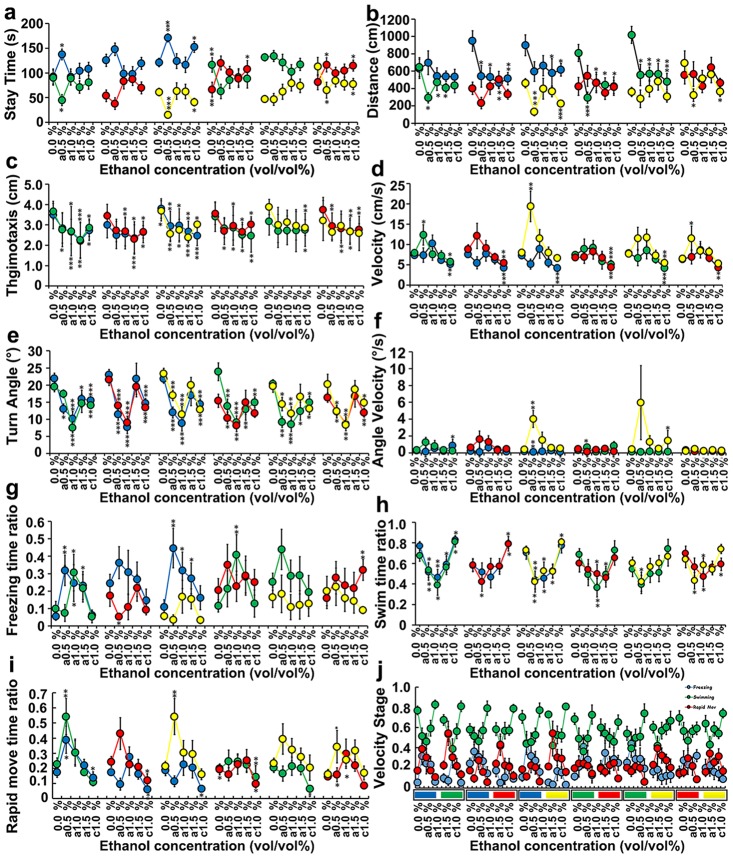
The effects of acute (0.5%, 1.0% and 1.5%) and chronic (1.0%) alcohol exposure on zebrafish behavioral parameters in six color combinations (12 color lumps) in color-enhanced conditional place preference tests.In each line chart, the six different color combinations (12 color lumps) located under the x-axis represent the different colors beneath the CPP compartments in the experiment. The five scales located under the y-axis indicate the five alcohol concentrations (vol/vol %) at which the zebrafish were treated. As shown in the line chart for each concentration, the coupled solid-colored balls represent the values of the behavioral parameters in the corresponding color compartment. The asterisks represent significant differences between the alcohol-treated and wild-type zebrafish. The data represent the means ± SEM of n = 12 zebrafish. * p < 0.05, ** p <0.01, ***p <0.001.